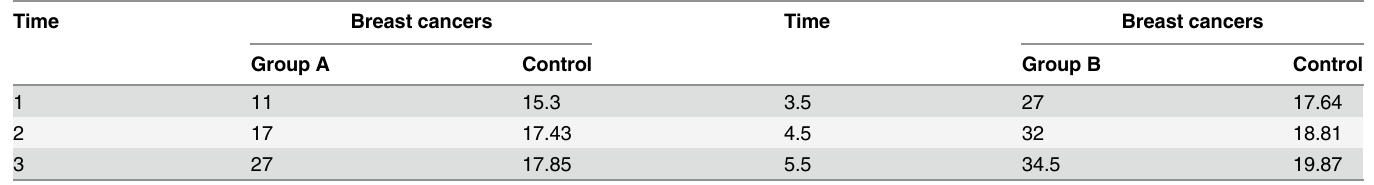
Table 2. (Scenario 2) The number of breast cancer cases in the intervention group for the short term users (Group A) and long term users (Group B).